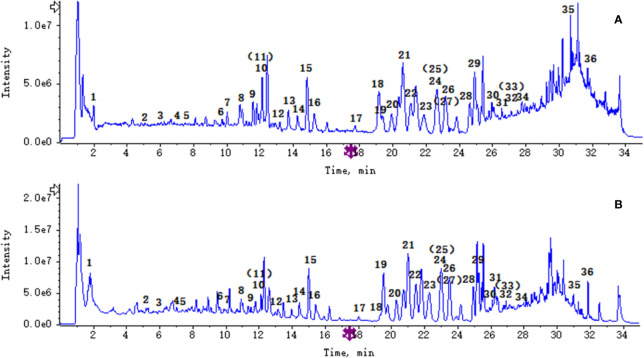
The total ion chromatograms total ion chromatogram (TICs) of Platycodon grandiflorum (PG) by ultra-performance liquid chromatography-quadrupole-time-of-flight tandem mass (UPLC/Q-TOF-MS/MS). (A) TIC of PG in positive ion mode; (B) TIC of PG in negative ion mode.